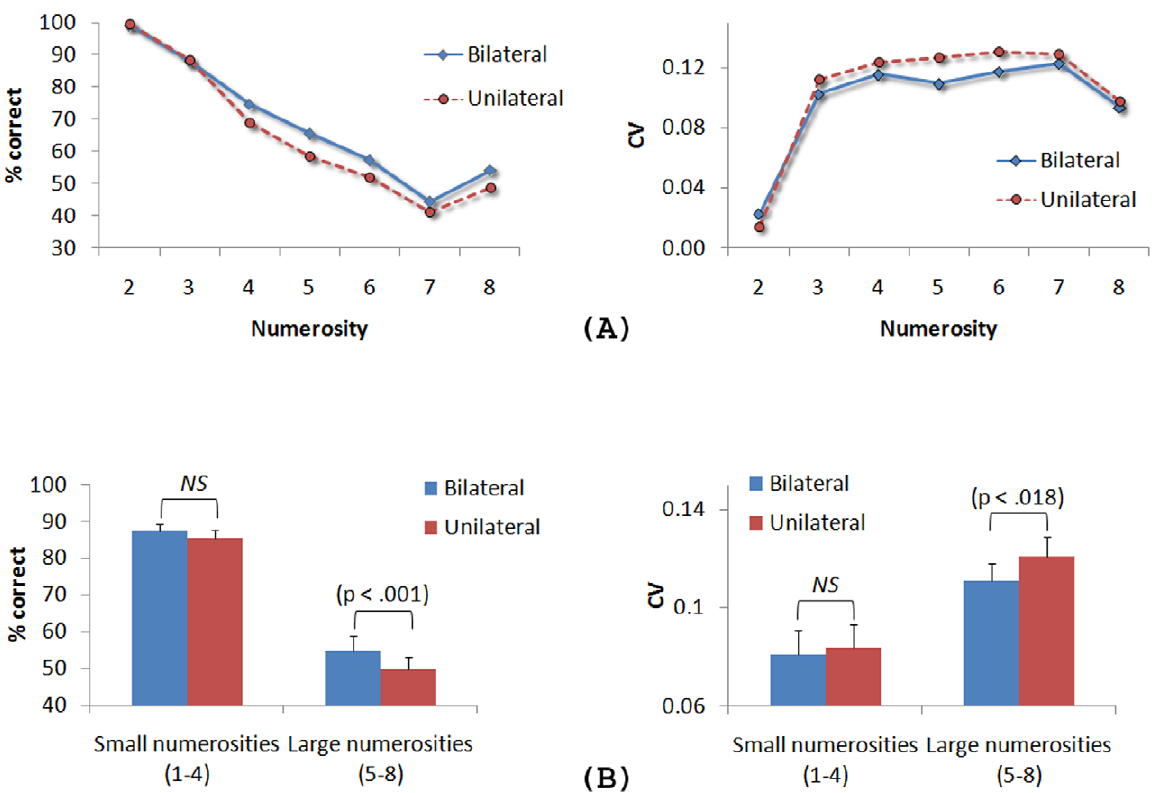
Figure 6. The results of Experiment 3. (A) Percentage of correct responses and coefficients of variation as a function of condition and numerosity. (B) Averaged percentage of correct responses and coefficients of variation divided across small and large numerosities. The error bars represent 6 1 standard error of the mean.